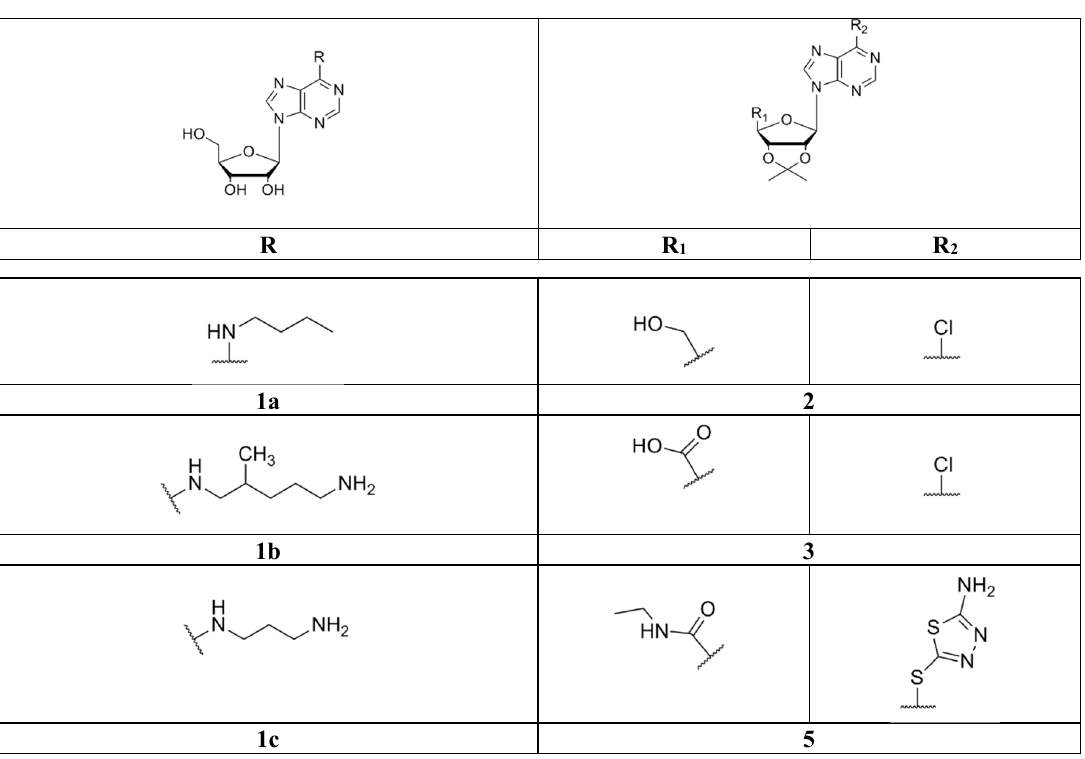
Figure 2. Chemical structure of derivative (compound) ( 4) , adenosine, and 6-chloropurine riboside.